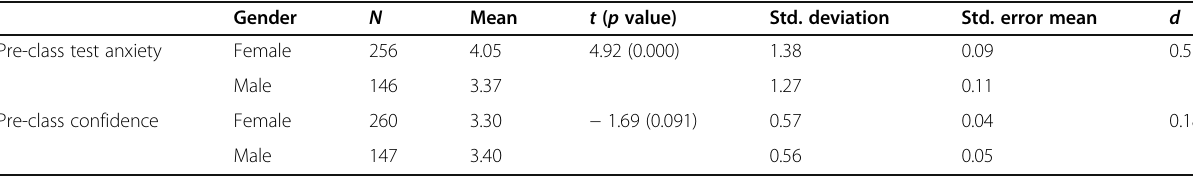
Table 1 Average confidence and test anxiety, by gender Gender N Mean t ( p value) Std. deviation Std. error mean